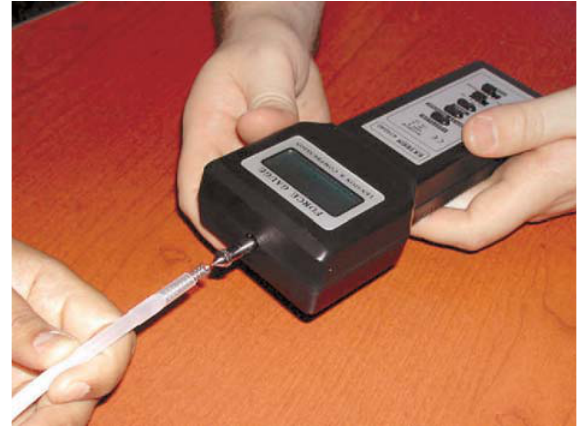
Figure 1 – Photograph of the hand-position taken by a left- handed individual being tested on an Extech TM Digital Force Gauge - model 475040. Participants were asked to hold the silicone portion and press on the tubing similar to advancing a catheter. A plastic shield (not shown) was placed between the force gauge and catheter to blind participants to their